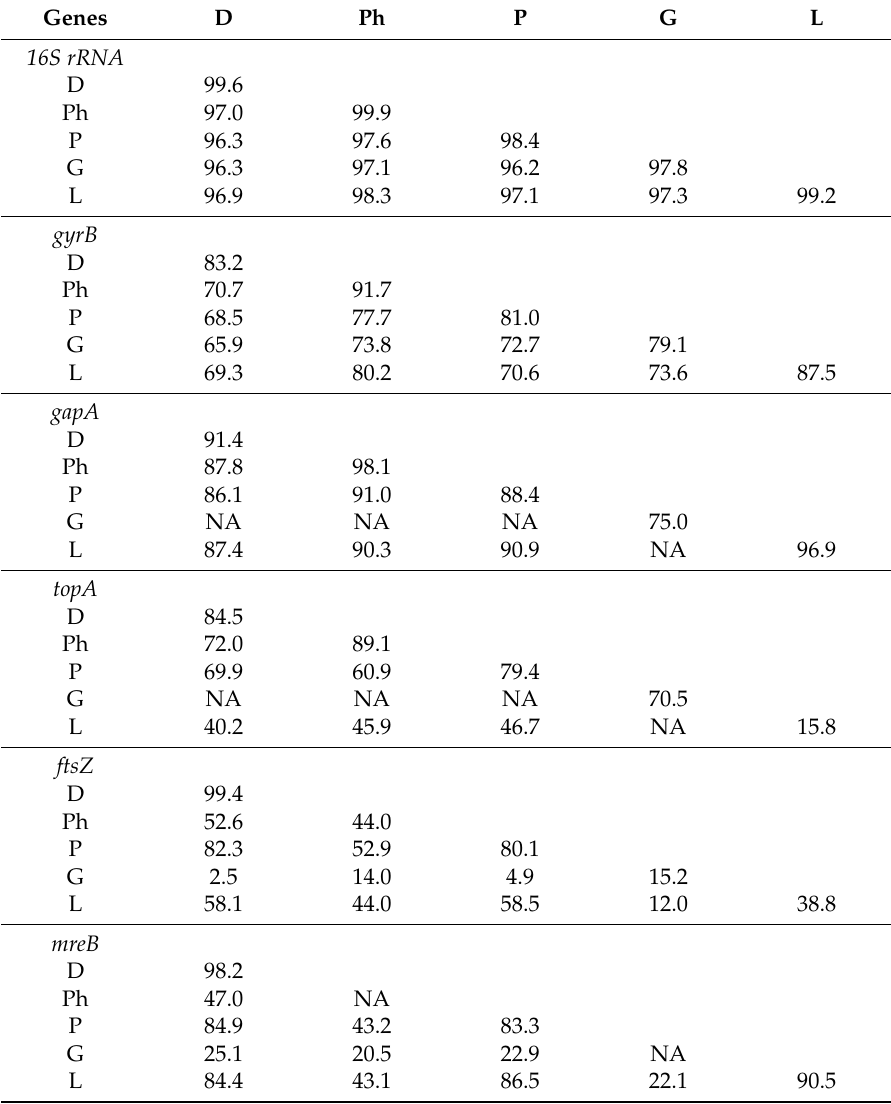
Table 2. Mean sequence similarities (%) between Photobacterium clades. D: Clade Damselae. (18 strains), Ph: Clade Phosphoreum (8 strains), P: Clade Profundum (5 strains), G: Clade Ganghwense (6 strains) and L: Clade Leiognathi (3